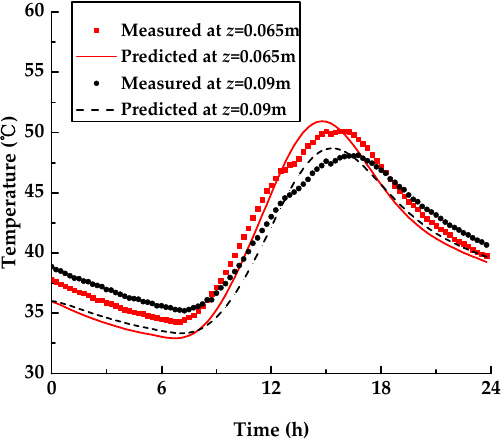
Figure 5. Measured and predicted temperature at z =0.02 m and z = 0.04 m on 24 August.